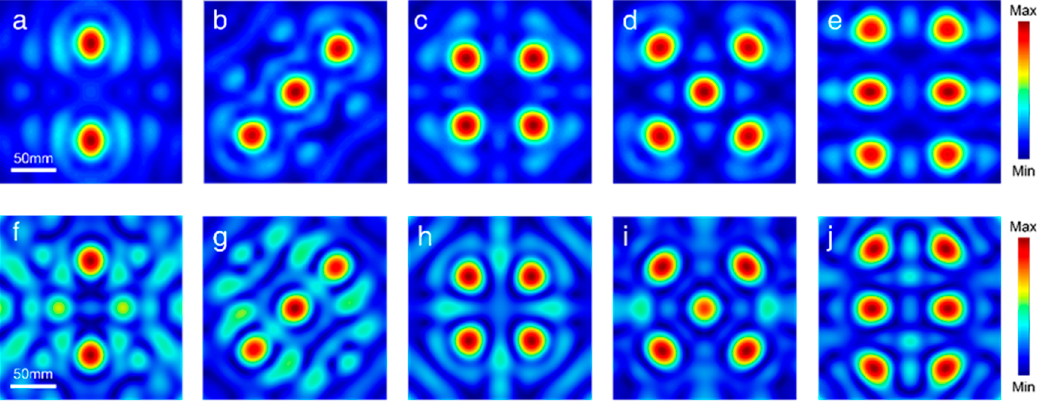
Figure 5. Amplitude distributions in multi-focal scenarios. ( a – e ) Calculated amplitude distributions of the acoustic field on the image plane when 2 to 6 spots were projected as the focal pattern, respectively. These amplitude distributions were rebuilt by discretized phases and a constant amplitude on the metasurface hologram planes. ( f – j ) Simulated amplitude distributions of the scattered acoustic field on the image plane. The distance between the two planes was 20 mm.